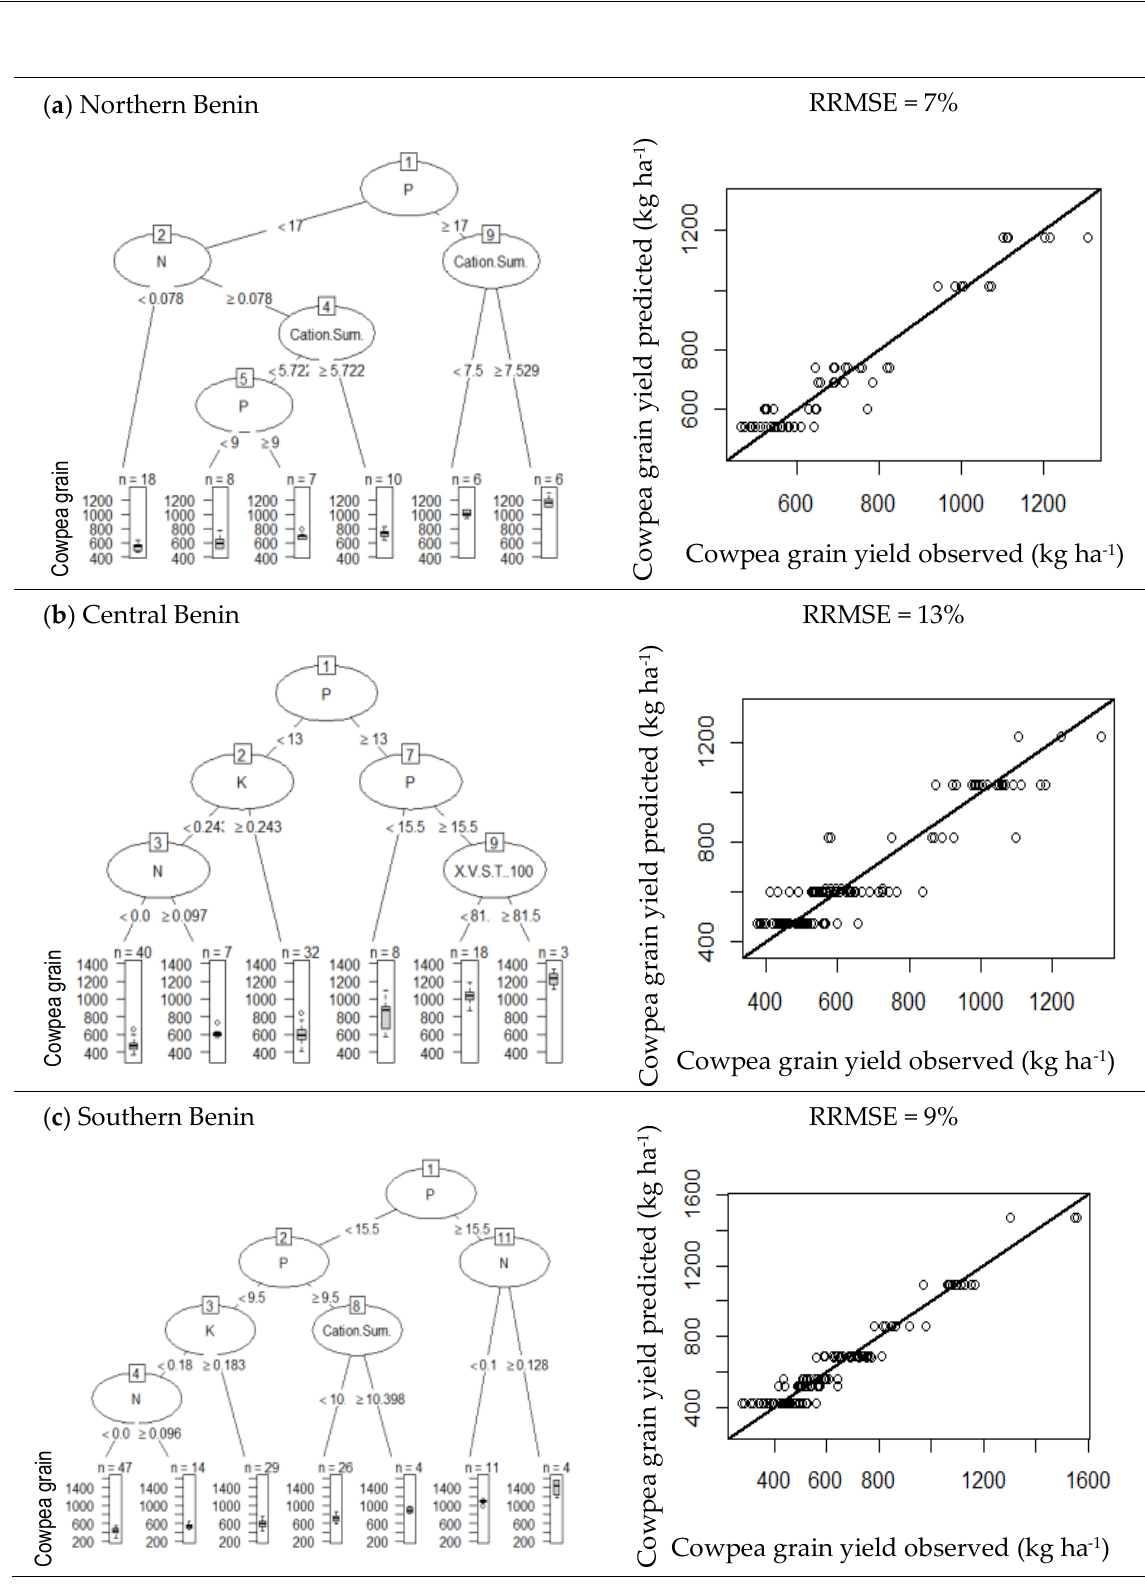
Figure 3. Model of regression tree of the agricultural practices driving cowpea grain yields from northern to southern Benin: ( a ) Northern Benin, ( b ) Central Benin, ( c ) Southern Benin. X.V.S.T is base saturation, N (x10 g kg −1 ), P (mg kg −1 ), K (cmol kg −1 ), Cation sum (cmol kg −1 ), X.V.S.T *100 (%).